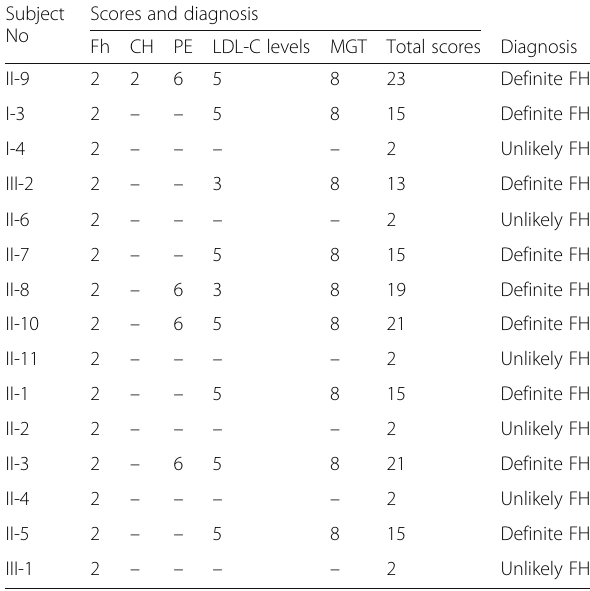
Table 4 The scores and diagnosis under the DLCN criteria Subject Scores and No